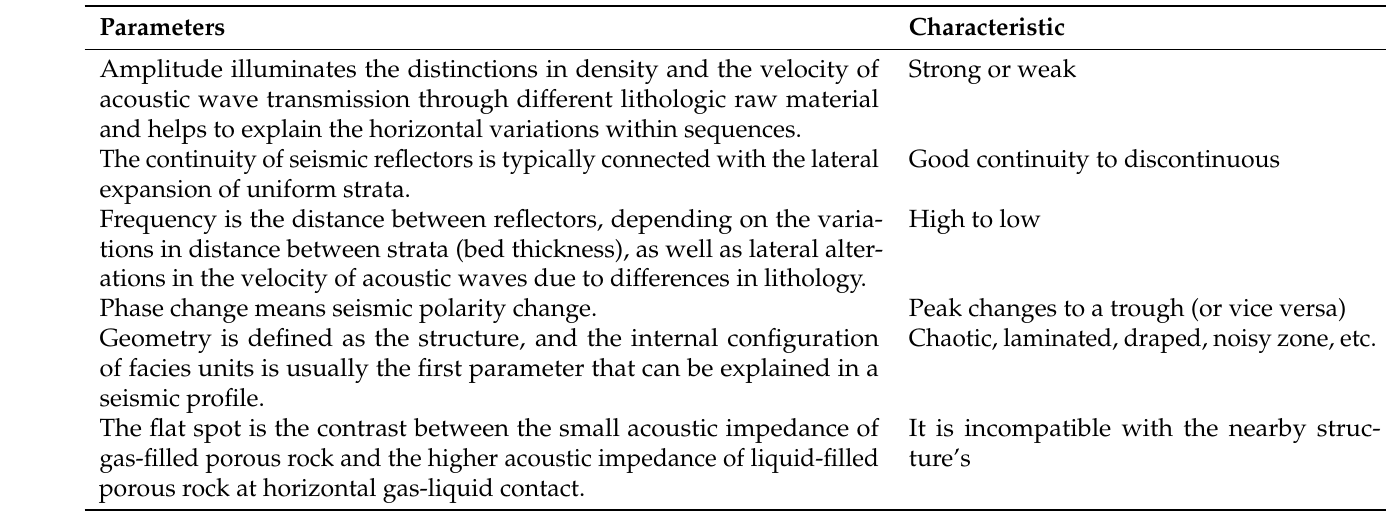
Figure 4. Reflection configurations of the seismic facies in the Taranaki Basin. Table 1. Seismic reflection parameters and their associated characteristics